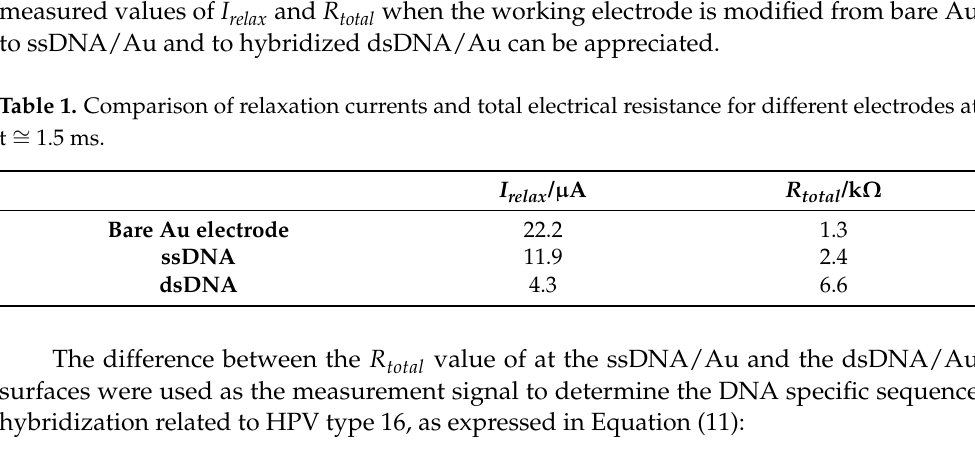
Figure 7. Relaxation current with external capacitor C out on different electrodes.